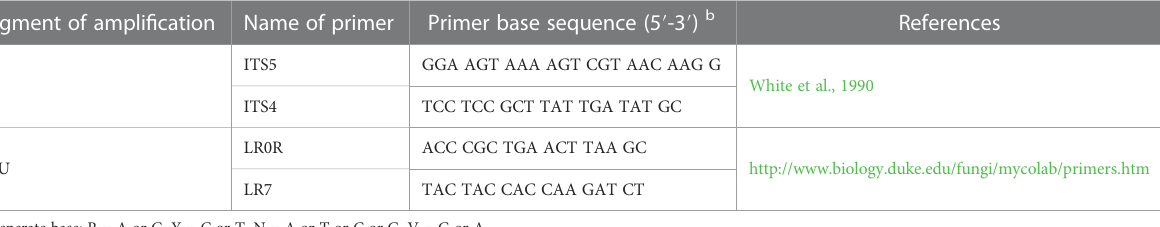
TABLE 1 A list of genes, primers and primer sequences used in this